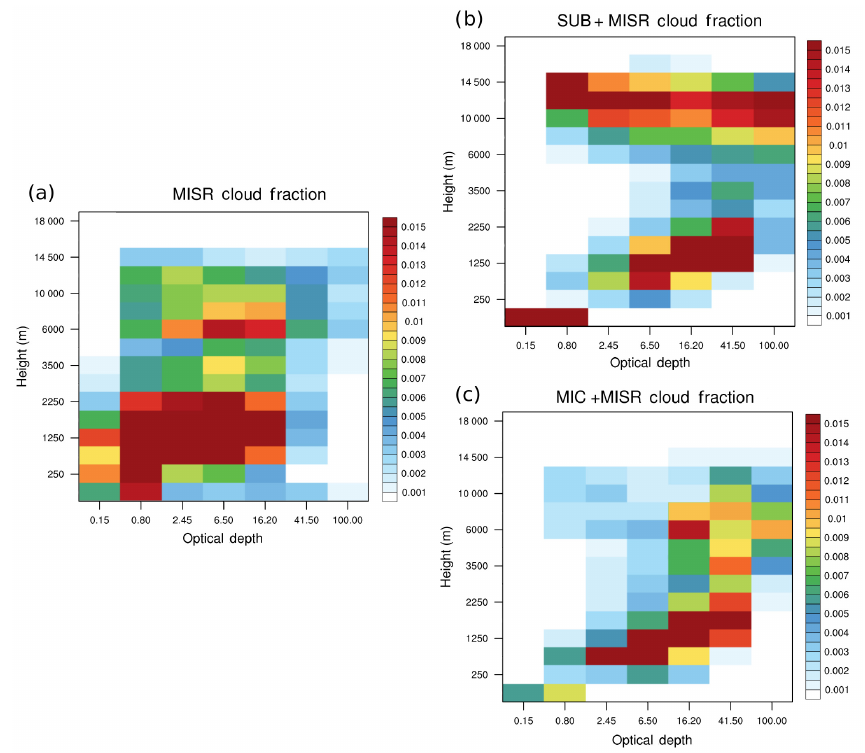
Figure 5. (a) Joint histograms of cloud top height and optical depth for MISR observations for JJA. (b) Joint histograms of cloud top height and optical depth for SUB using the MISR simulator for JJA. (c) Joint histograms of cloud top height and optical depth for MIC using the MISR simulator for JJA. The colour scale represents the cloud fraction in non-dimensional units, from 0 to